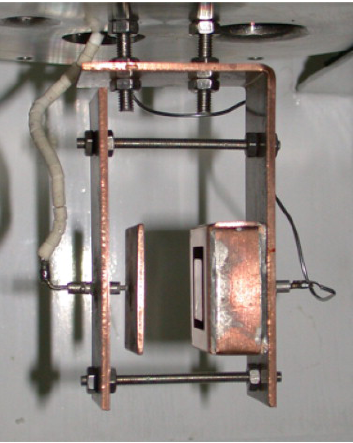
Figure 1. Picture of the sample holder provided with copper electrodes in order to induce deuterium ion loading by an applied electric